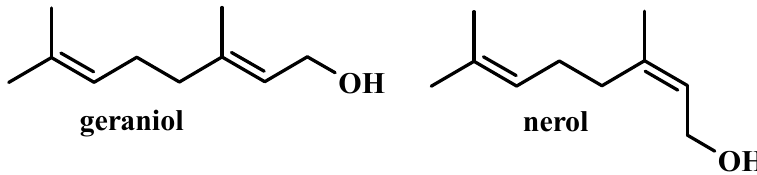
Figure 1. Chemical structure of geraniol and nerol.